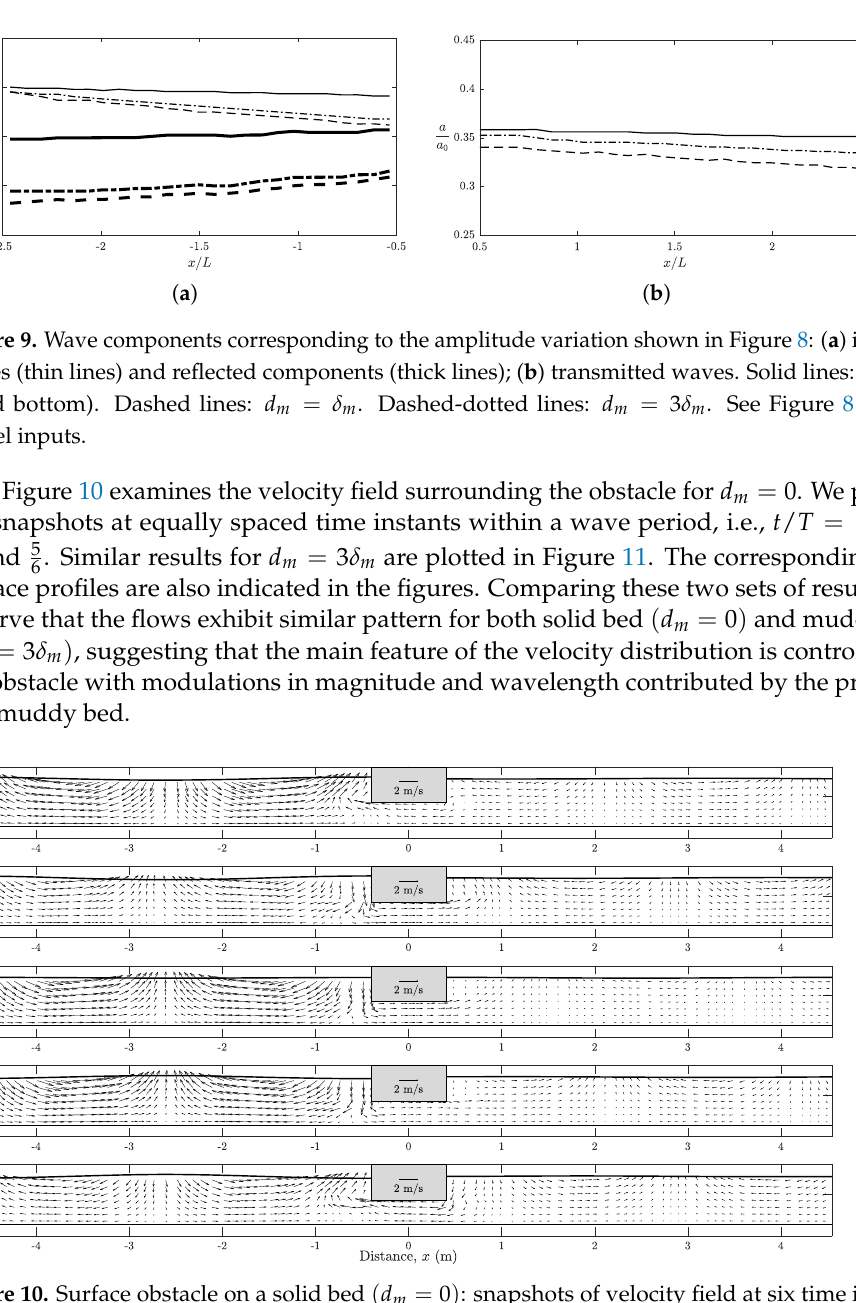
, 2 , 3 , 4 , and 5 . Solid line indicates the free surface. The 6 6 6 6 6